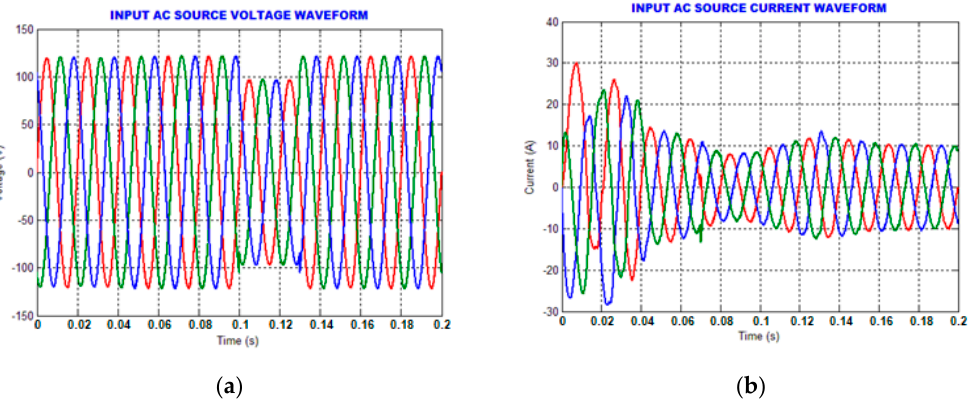
Figure 9. ( a ) Source voltage waveform ( b ) Source current waveform.